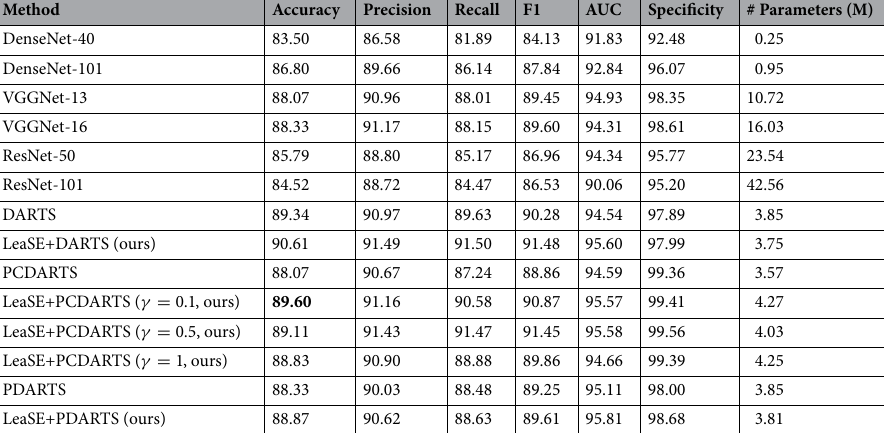
Table 3. Test accuracy (%), precision (%), recall (%), F1 (%), AUC (%), specificity (%), and the number of model parameters (millions) of different methods. DenseNet-40 denotes a DenseNet with 40 layers. Similar meanings hold for other notations in such a format.